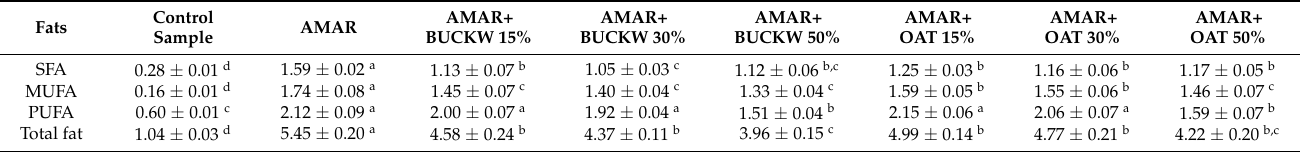
Table 5. Fat composition of pasta (g 100 g − 1 ).